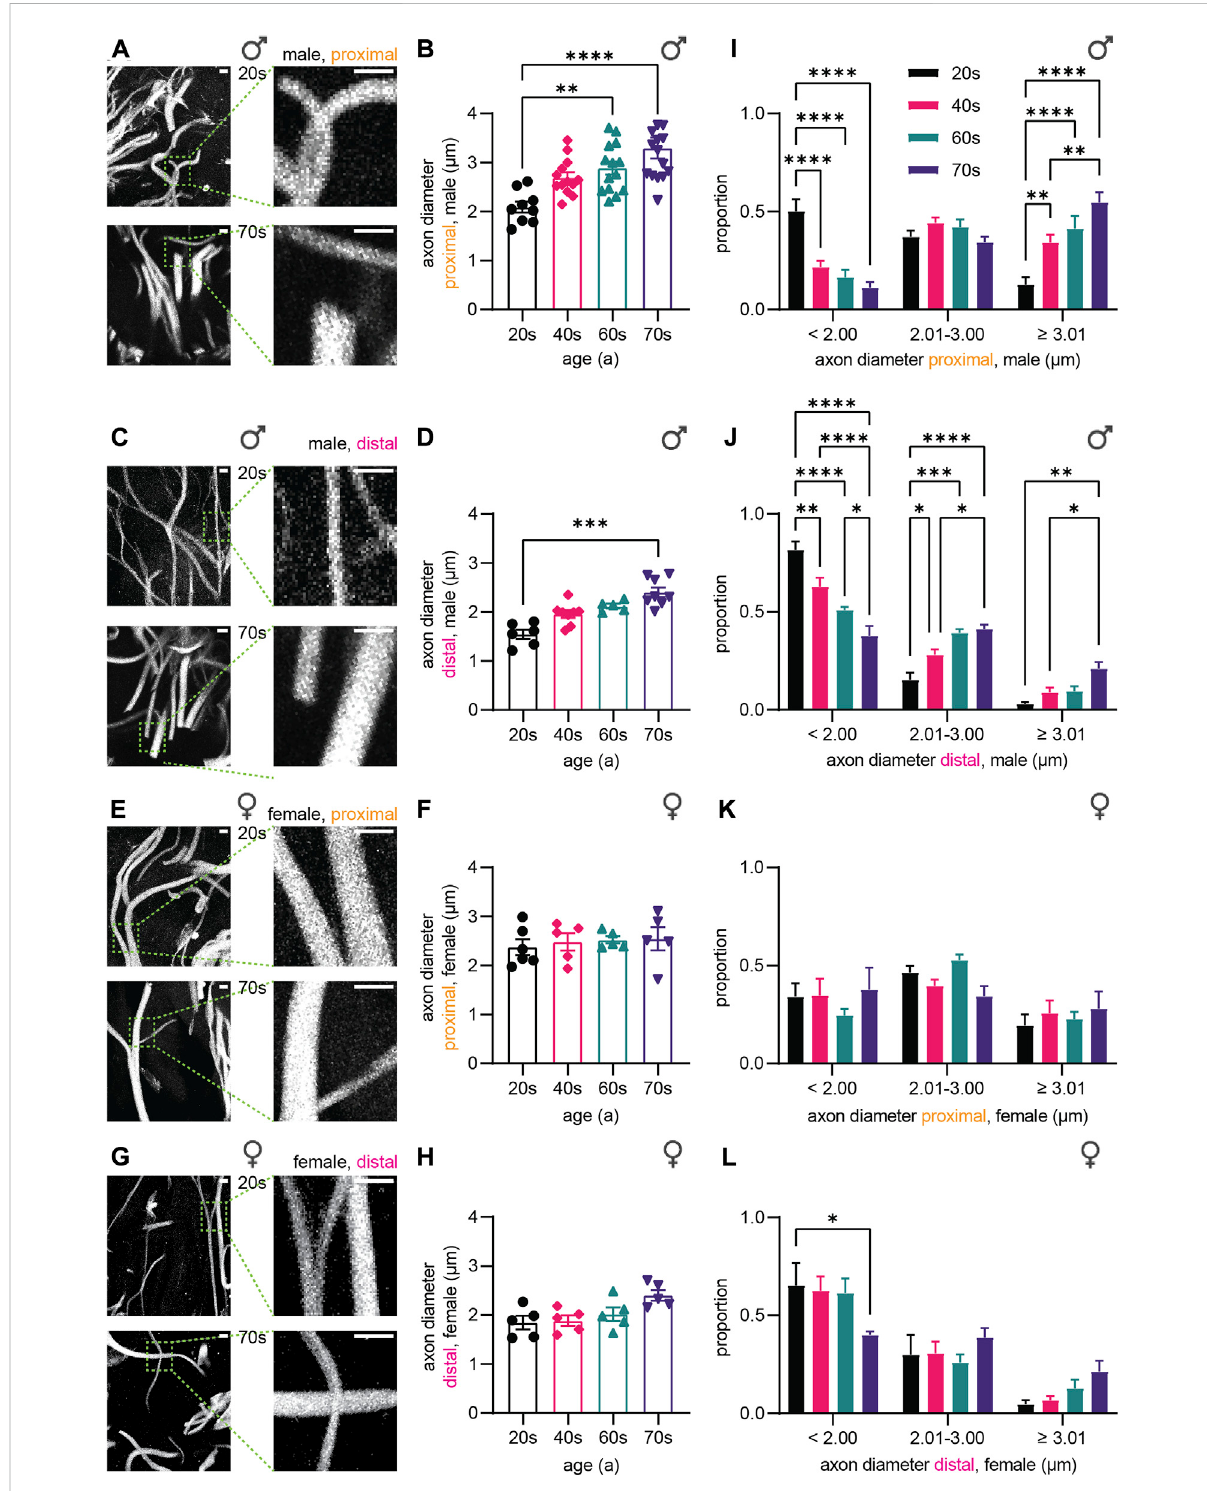
FIGURE 2 Quantitative analysis of the axonal diameter. (A,C,E,G) Confocal images of TUBB3 immunostaining (white) of skin biopsies from (A) male proximal, (C) maledistal, (E) female proximal, and (G) female distalleg. (B,D,F,H) Graphsdepictaxondiameter(µm)in (B) maleproximal, (D) maledistal, (F) female proximal,and (H) femaledistalskinbiopsies(3imagesperindividual, ≤ 20axonsperimage). (I – L) Axondiameterdistributionforthe (I) maleproximal, (J) maledistal, (K) femaleproximal,and (L) femaledistalsamplesets.Diameterspansarede fi nedasfollows: < 2.00 µm,2.01 ≤ ... < 3.00 µm, ≥ 3.01 µm. Scale bars in (A,C,E,G) are 5 µm. Points in graphs (B,D,F,H) symbolize one individual. Data represent mean ± SEM. (B,D,F,H) Kruskal – Wallis test with Dunn ’ s multiple comparisons test. (I-L) Two-way ANOVA with Tukey ’ s multiple comparisons test. * p < 0.05, ** p < 0.01, *** p < 0.001, **** p <